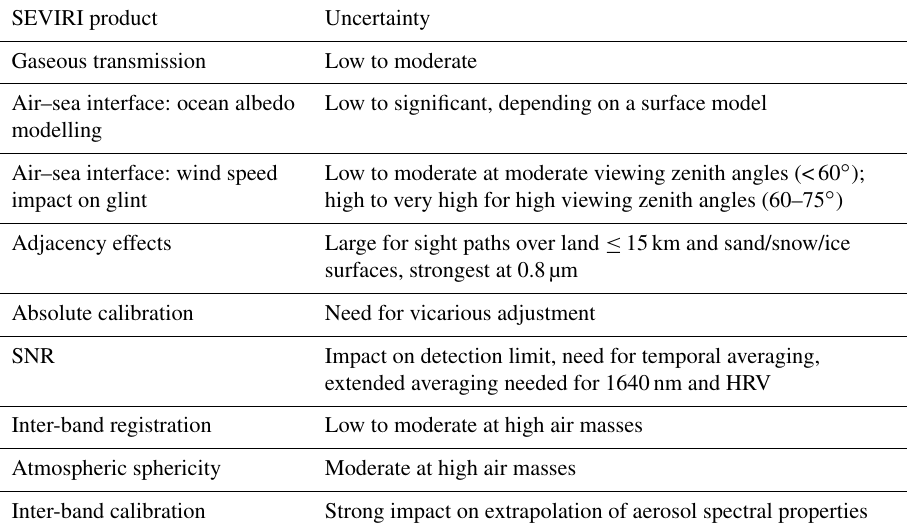
Table 5. Summary of conditions contributing to SEVIRI ocean colour product uncertainties, where the largest errors arise at high air masses, in the sun-glint geometry and at high aerosol optical